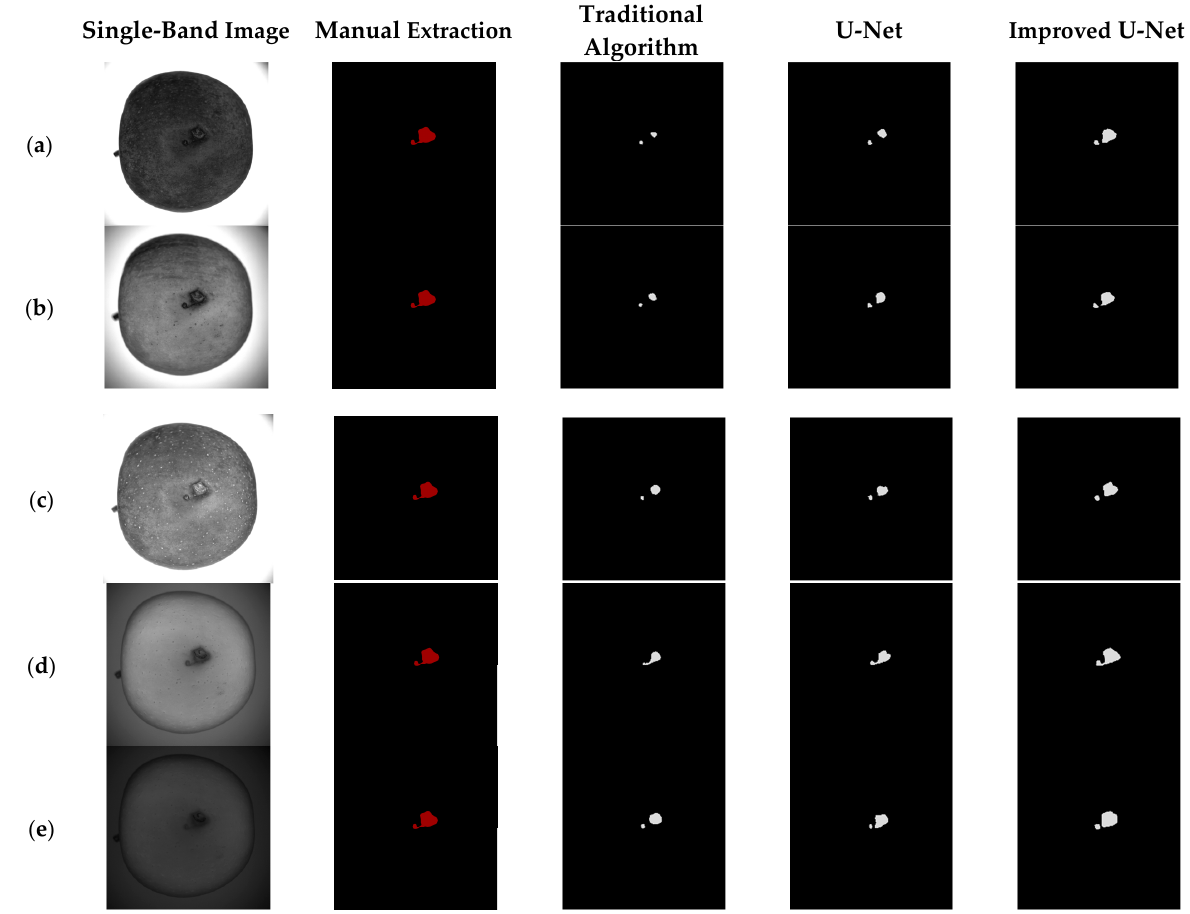
Figure 14. Single-band image, manual extraction of the defects with small areas and irregular edges, and algorithmic extraction of the defects with small areas and irregular edges: ( a ) 460 nm ( b ) 522 nm ( c ) 660 nm ( d ) 762 nm( e ) 842 nm.